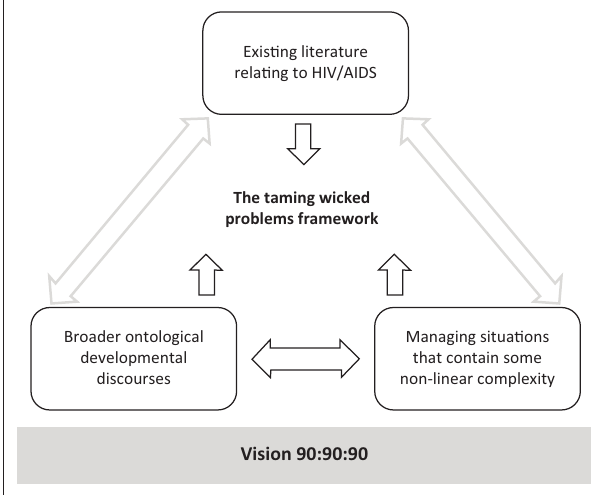
FIGURE 1: Factors that influenced the development of the